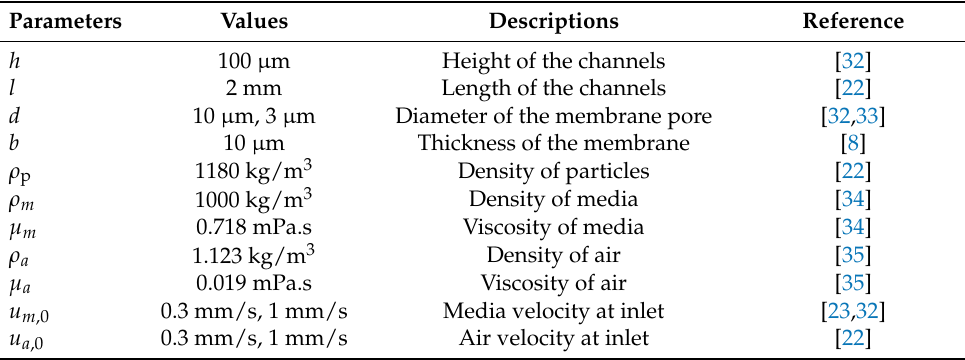
Table 2. The values of the parameter used for the numerical simulations. Parameters Values